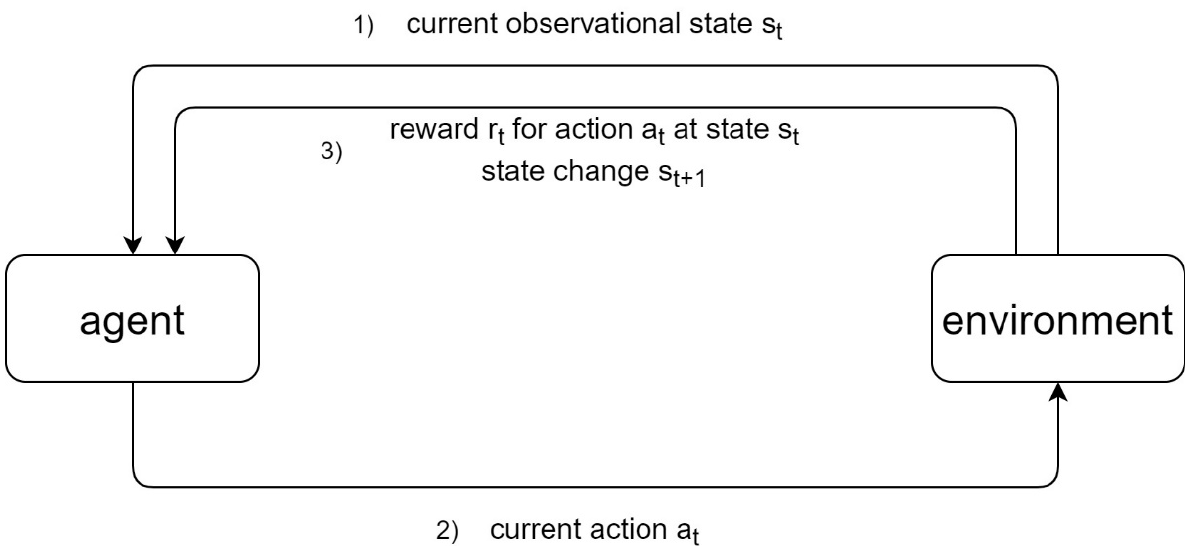
Figure 2. Concept of reinforcement learning. An agent receives current state observations from an environment (1) and, in response, selects an action according to its policy (2). For this action, the agent receives a reward based on a reward function and the state of the environment changes (3). The agent’s goal is to maximize long-term rewards and achieve the optimum possible return.